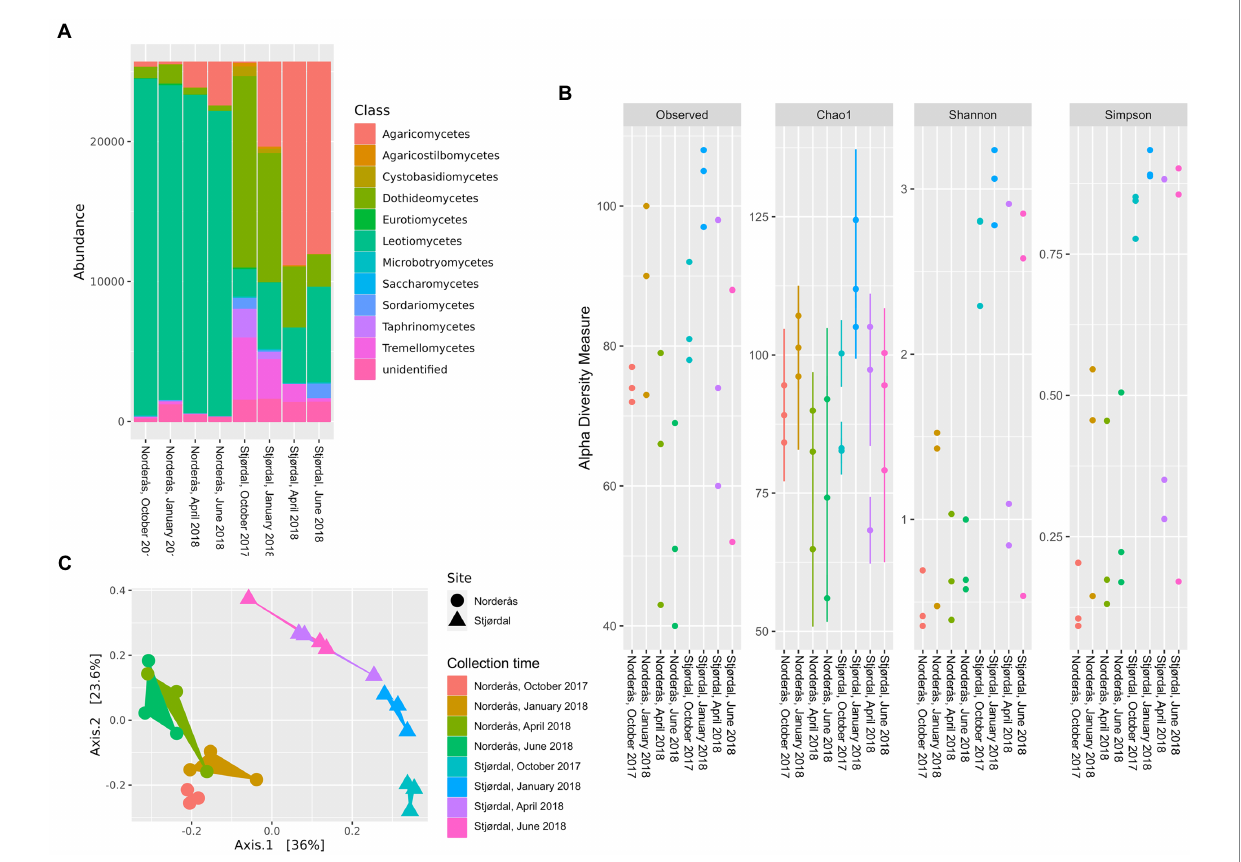
FIGURE 2 (A) Class-level distribution of the petiole-associated fungal communities from the diseased (Norderås) and healthy (Stjørdal) sites over four collection time points. (B) Alpha diversity indices of petiole mycobiomes from the diseased (Norderås) and healthy (Stjørdal) sites, and (C) principal coordinate analysis (PCoA) based on Bray–Curtis dissimilarity matrices showing the separation of mycobiomes from each site and